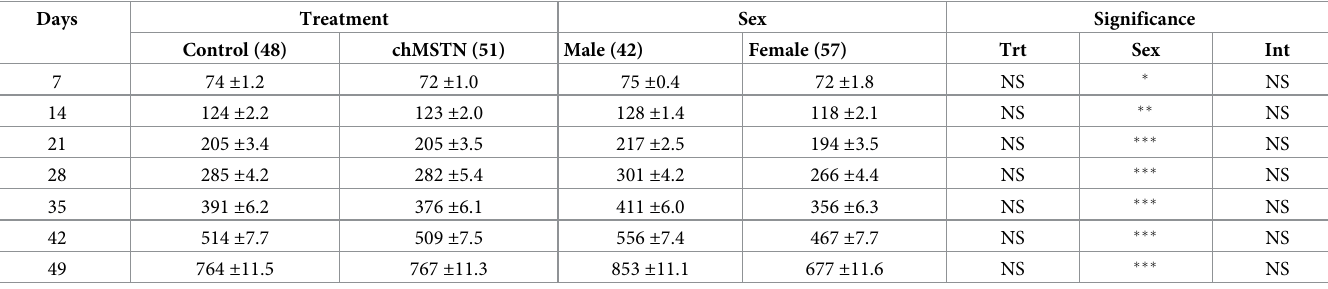
Table 1. Body weight of chicks from the Control and chMSTN groups in Experiment